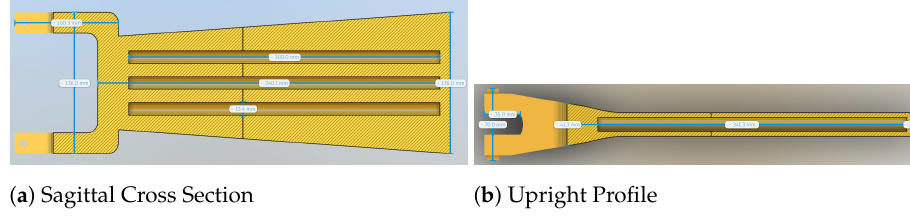
Figure 5. RoboFish Perspectives of the Tail’s Cross